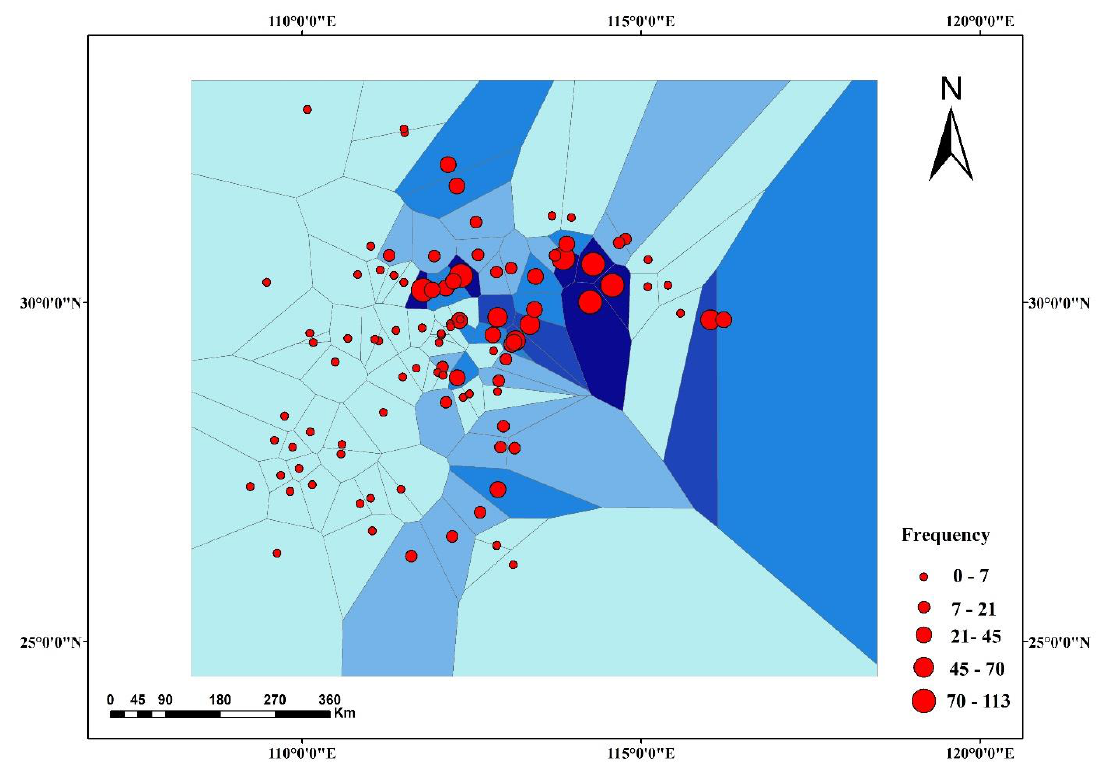
Figure 15. Graduated frequency and distribution of flood alarming events.